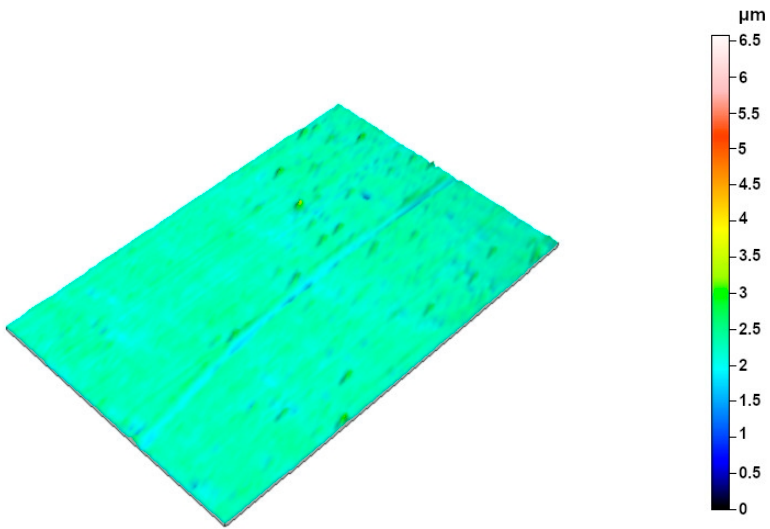
Figure 5. Optical micrograph of the sapphire ball after a tribological test.